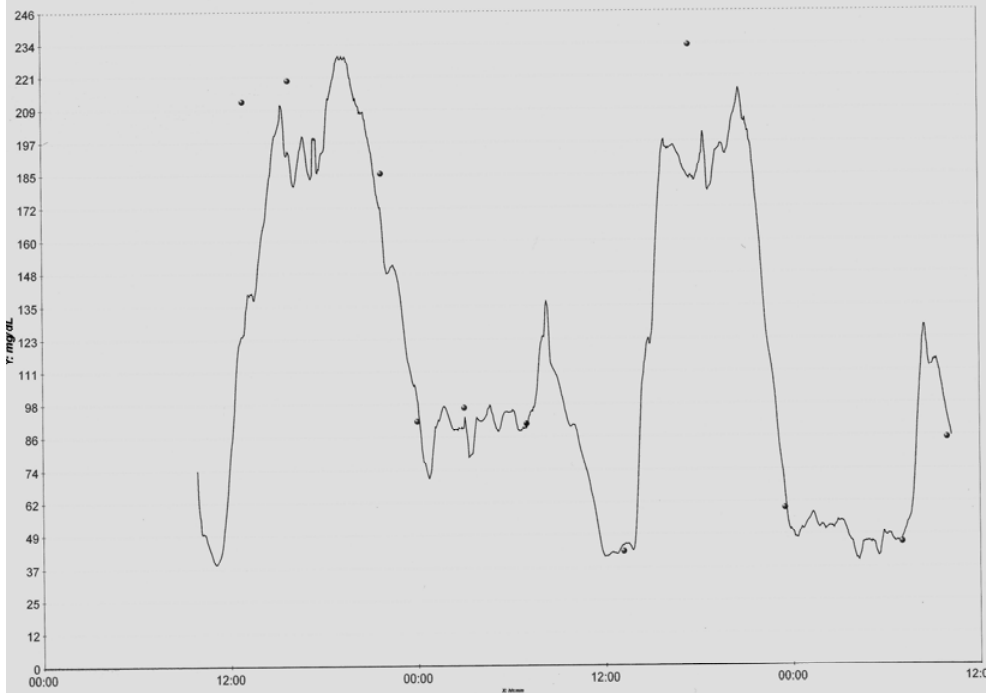
Figure 1. Representative graph of the glucose values obtained using the GlucoDay system in a patient with Type 1 DM. Note the wide variations in glycemia values, and the nocturnal